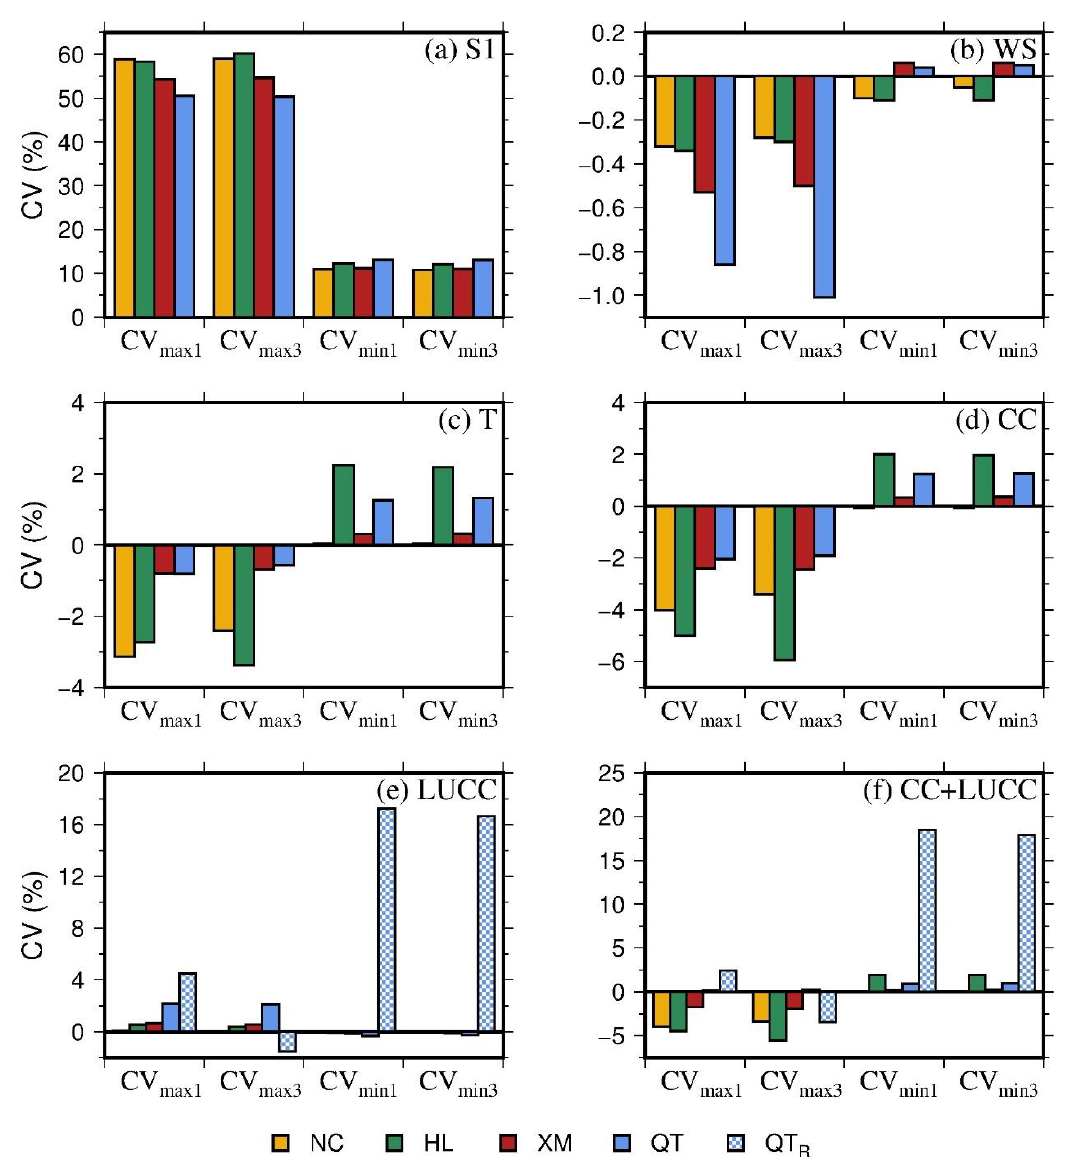
Figure 7. Extreme streamflow variability (CV max1 , CV max3 , CV min1 , CV min3 ) under scenario 1 baseline ( a ) and the impacts of wind speed change ( b ), temperature change ( c ), climate change ( d ), land use/cover change ( e ), and both climate change and land use/cover change ( f ).